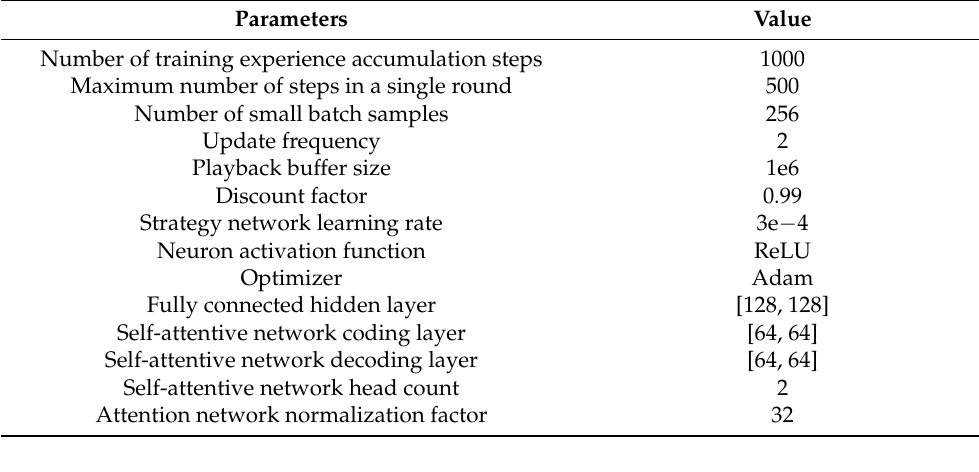
Table 6. Training hyperparameters and neural network structure.